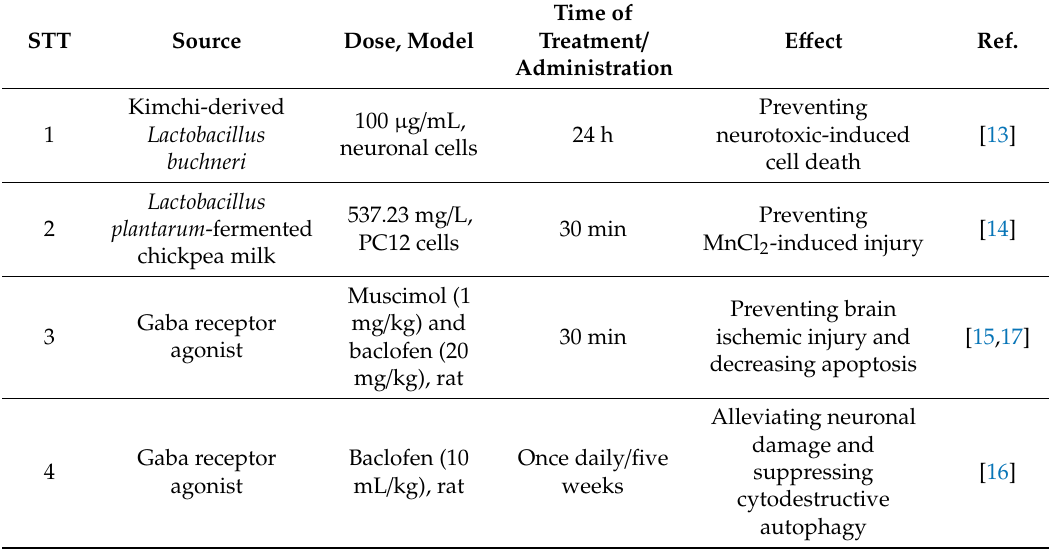
Table 1. Neuroprotective e ff ect of